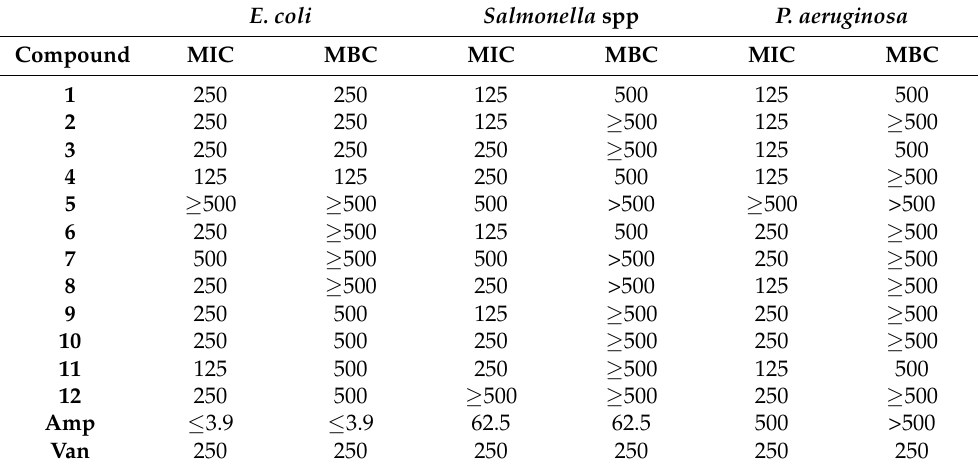
Table 1. MIC and MBC ( µ g/mL) of the tested flavonoids against Gram-negative bacteria. E. coli Salmonella spp P.